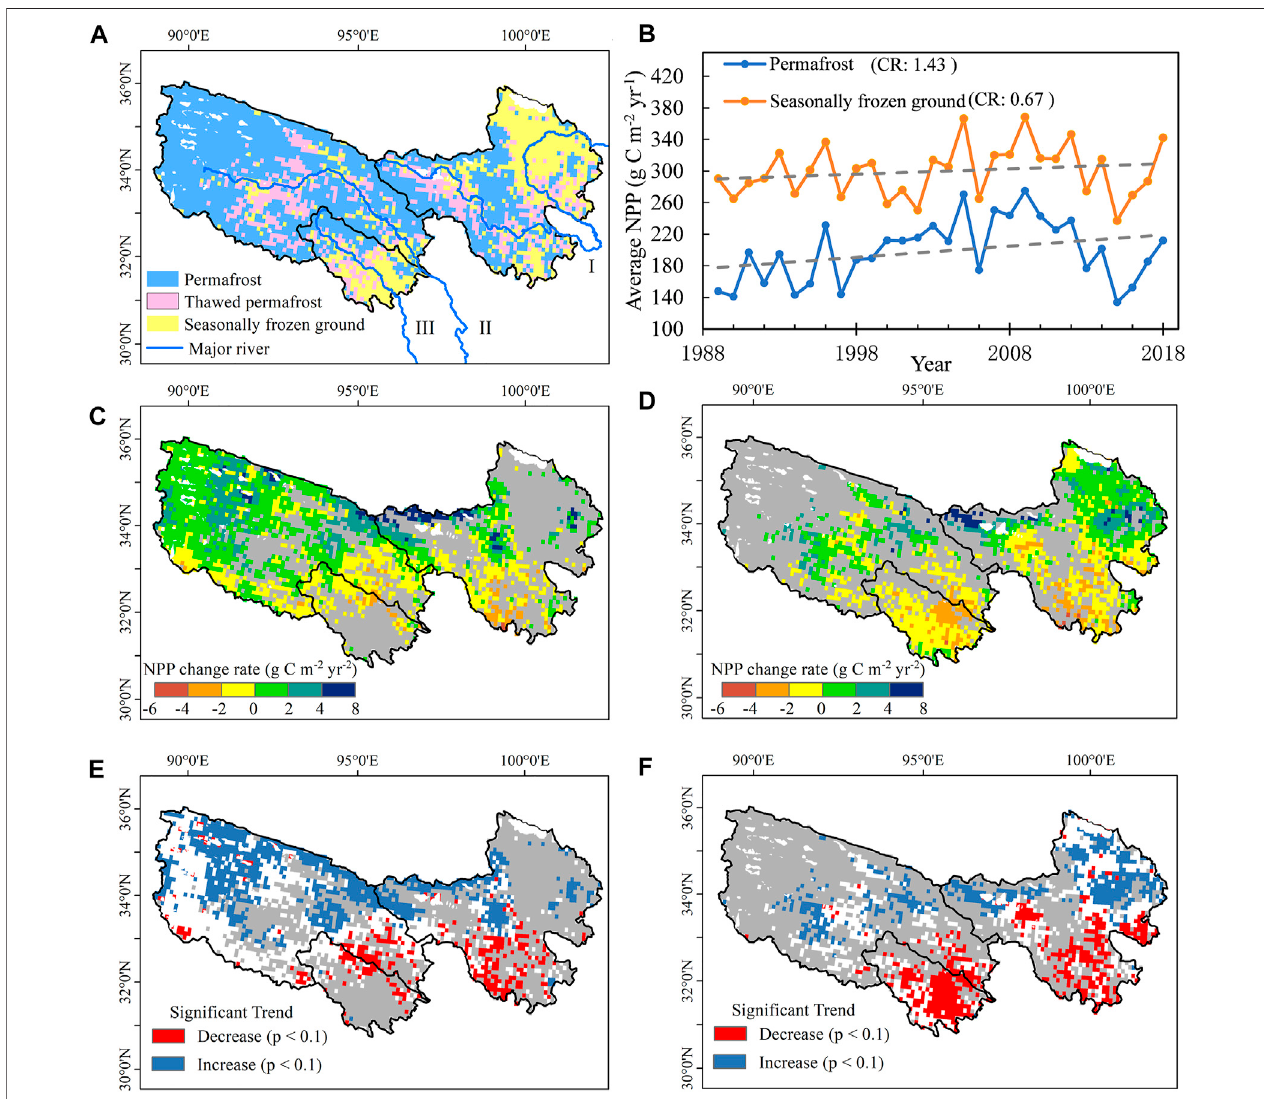
FIGURE7| DistributionoffrozengroundtypeintheTRHRin2018 (A) ,inter-annualvariabilityofNPPintheTRHRstrati fi edbyfrozengroundtype (B) ,andtherates of change in NPP in the permafrost zone (C) and the seasonally frozen ground (SFG) zone (D) in the TRHR from 1989 to 2018 based on a 30-year Noah-MP simulation, as well as signi fi cance tests for the trends in the permafrost zone (E) and SFG zone (F) . The thawed permafrost in (A) was identi fi ed relative to the beginning of the simulation. I, II, III represent the Yellow River, the Yangtze River and Langcang River, respectively. The gray dashed lines in (B) represent the trend from 1989 to 2018. Lakes are excluded from the maps. CR: the rate of change in a unit of g C m − 2 yr − 2 . The blank areas in (E,F) indicate a p value > 0.1.